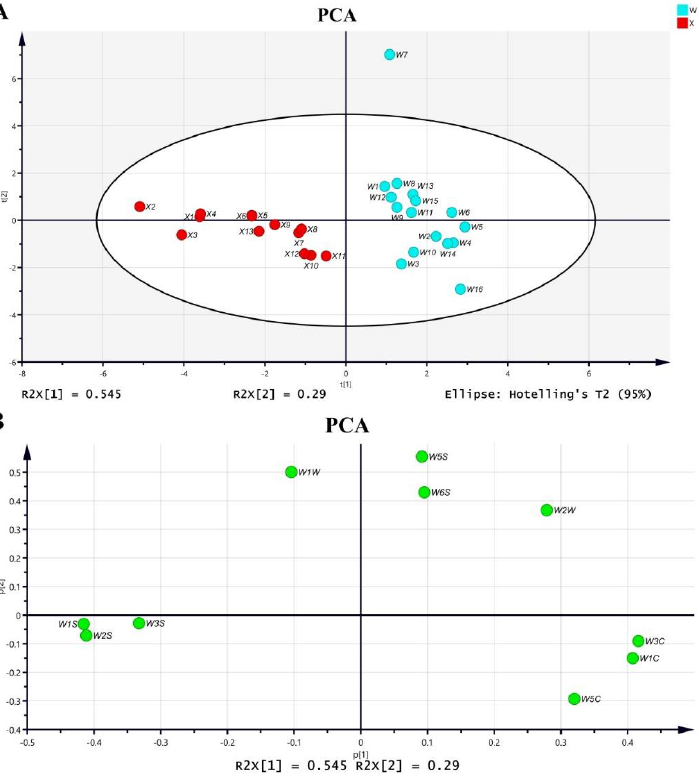
Figure 1. PCA plot of flavor profiles among the herbs. ( A ) PCA score plot representing the samples; ( B ) PCA loading plot representing the variables.